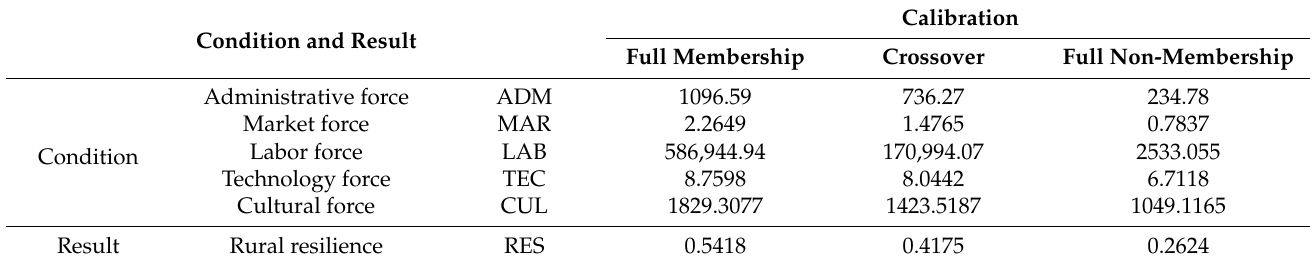
Table 6. Calibration table of conditions and result